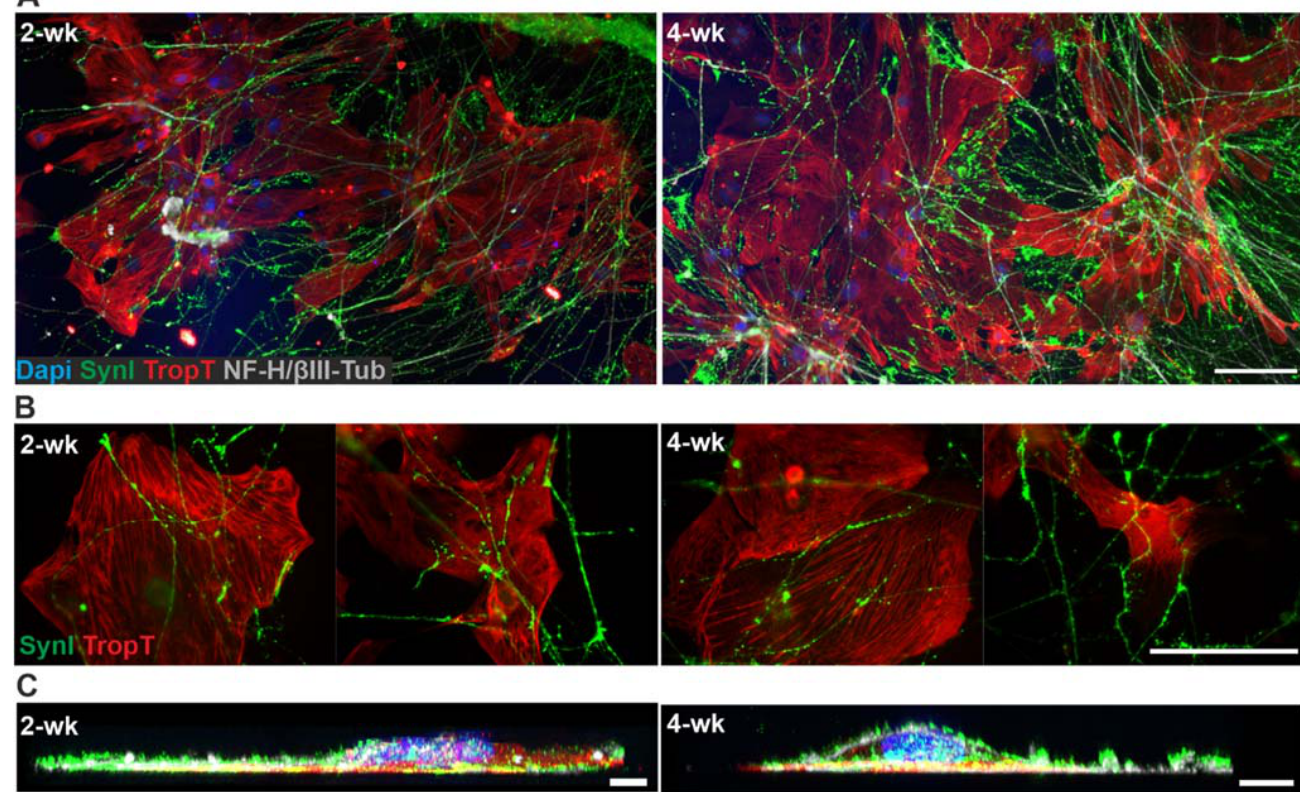
Figure 2. ICC staining of the hiPSC ‐ derived neuron–CM coculture in the 3D3C chip at 2 ‐ and 4 ‐ week timepoints. ( A ) The staining showed the extension of the neuronal axons (NF ‐ H/ β III ‐ Tub, white) in the middle compartment among the CMs (TropT, red) and that both cell types were viable when in close contact with each other at both timepoints. ( B ) The staining of the synaptic marker (SynI, green) showed evidence of possible axon ‐ mediated synaptic interactions with the CMs at both timepoints. The channels are shown separately in the Supplementary Figure S2. ( C ) 3D projection of the neuron–CM coculture showed that axonal synapses grew in close contact with CMs (NF ‐ H/ β III ‐ Tub, white; SynI, green; TropT, red). The scale bar is 100 μ m for ( A ) and ( B ) and 10 μ m for ( C ). Blue indicates a nuclear marker (DAPI).